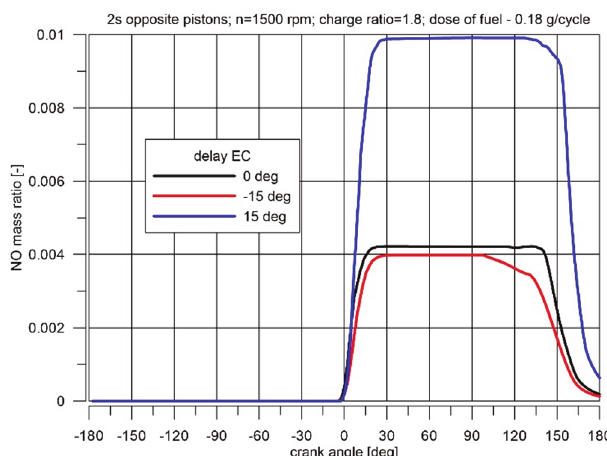
Fig. 17. Variation of NO mass ratio in cylinder of 2sOPE with different delay of exhaust port